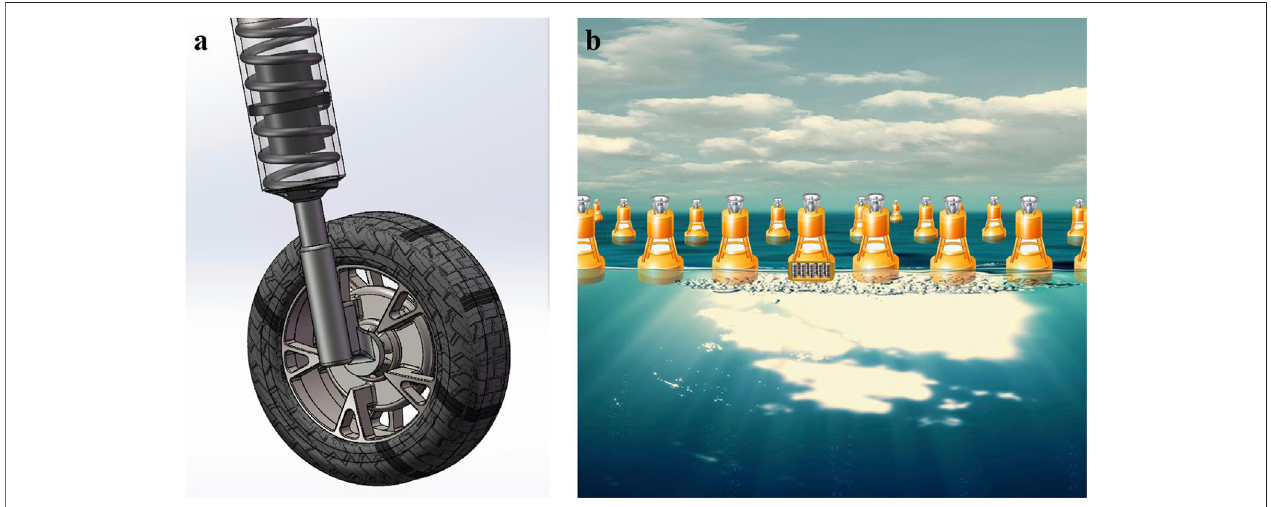
FIGURE 11 | (A) LM-FTG in car suspension. (B) LM-FTG in the ocean